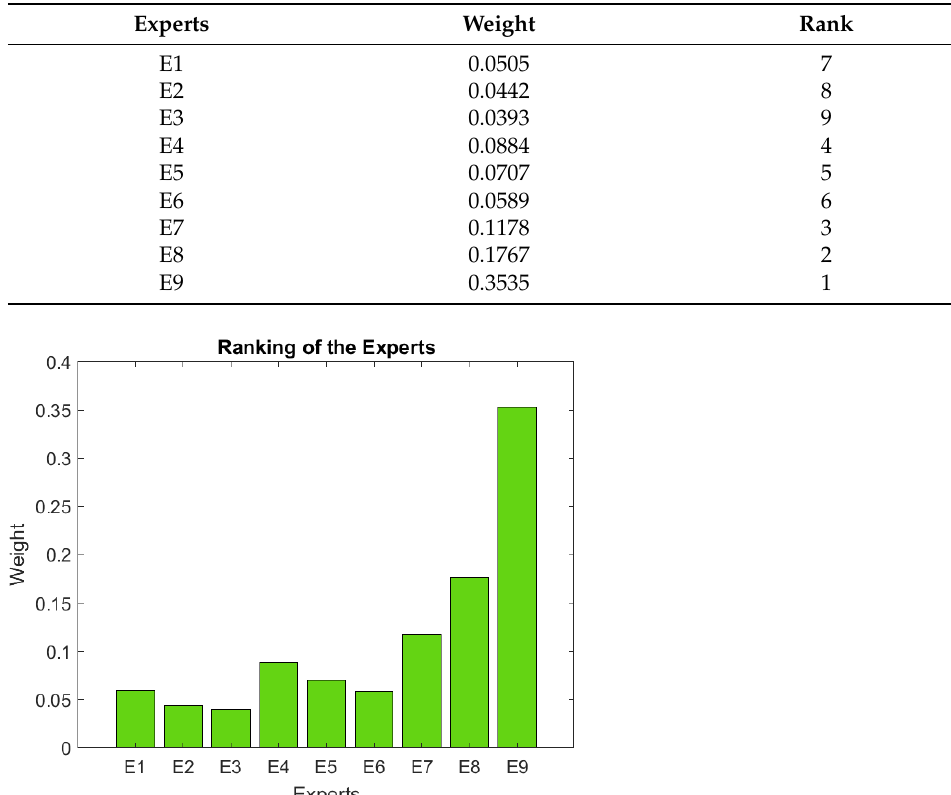
Table 9. Significance and ranking of the experts.